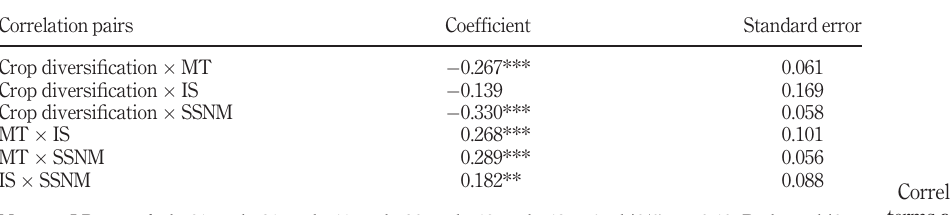
Table III. Correlation of